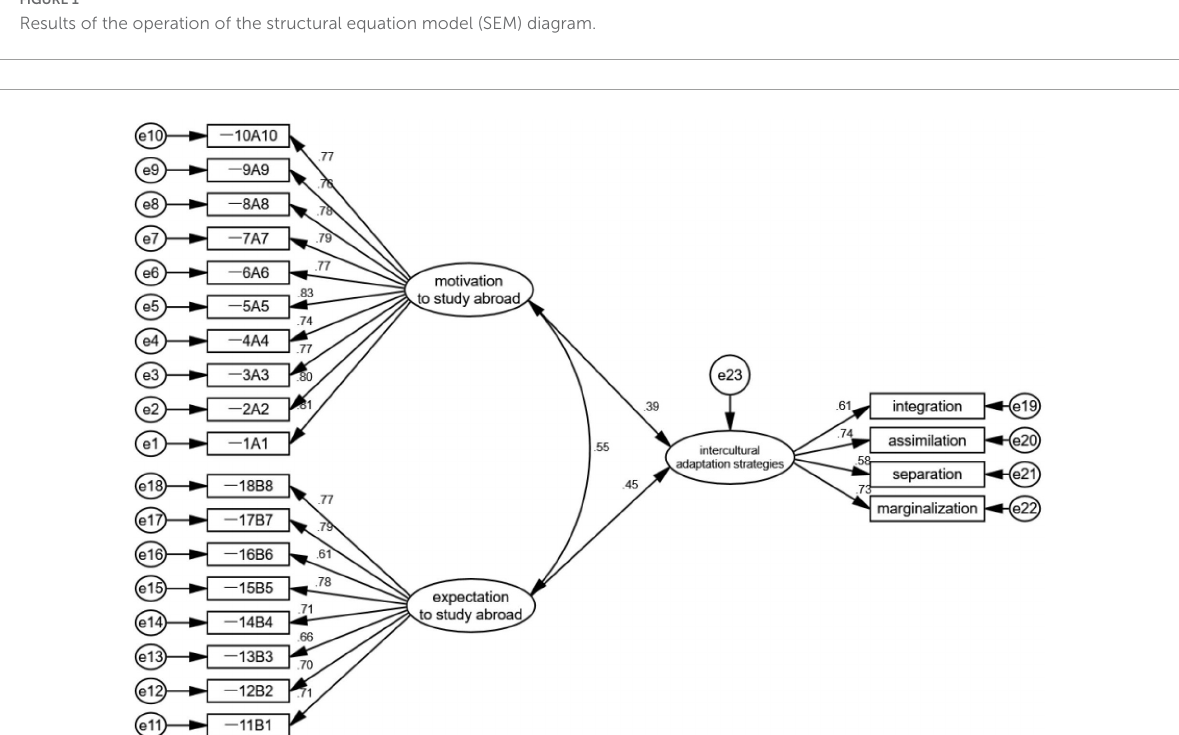
FIGURE2 Results of the structural equation modeling of the motivation to study abroad, the expectation to study abroad, and the intercultural adaptation strategies.